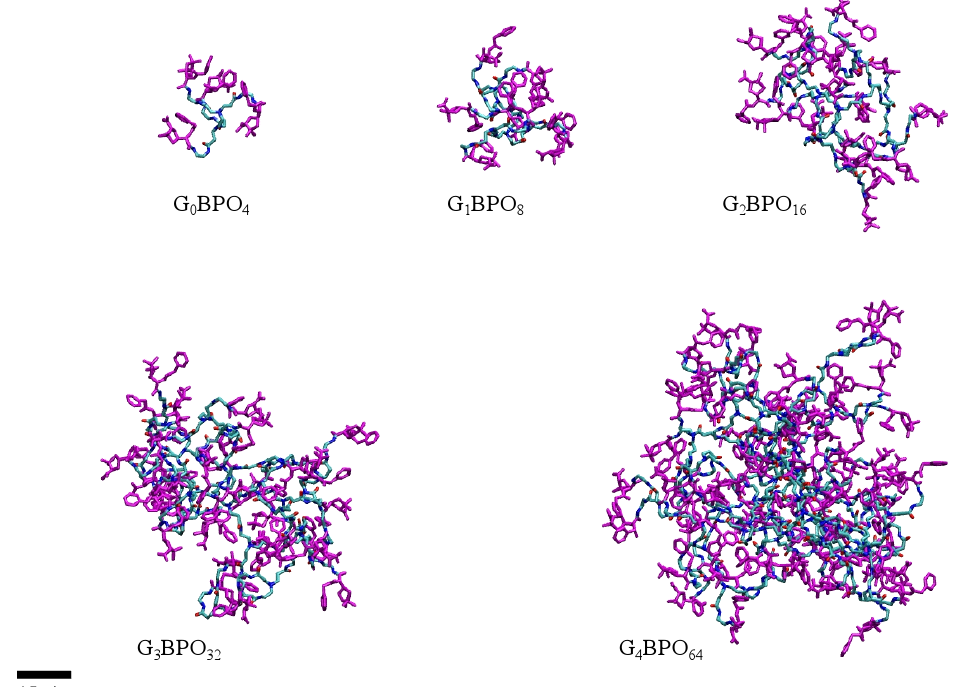
Figure 9. Selected snapshots of G